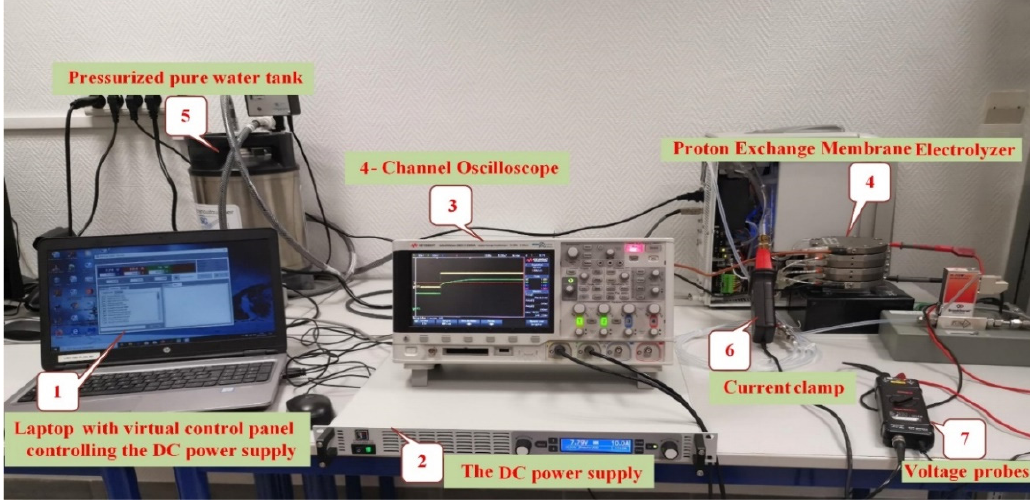
Figure 17. Investigation of dynamic operation of a PEMEL.